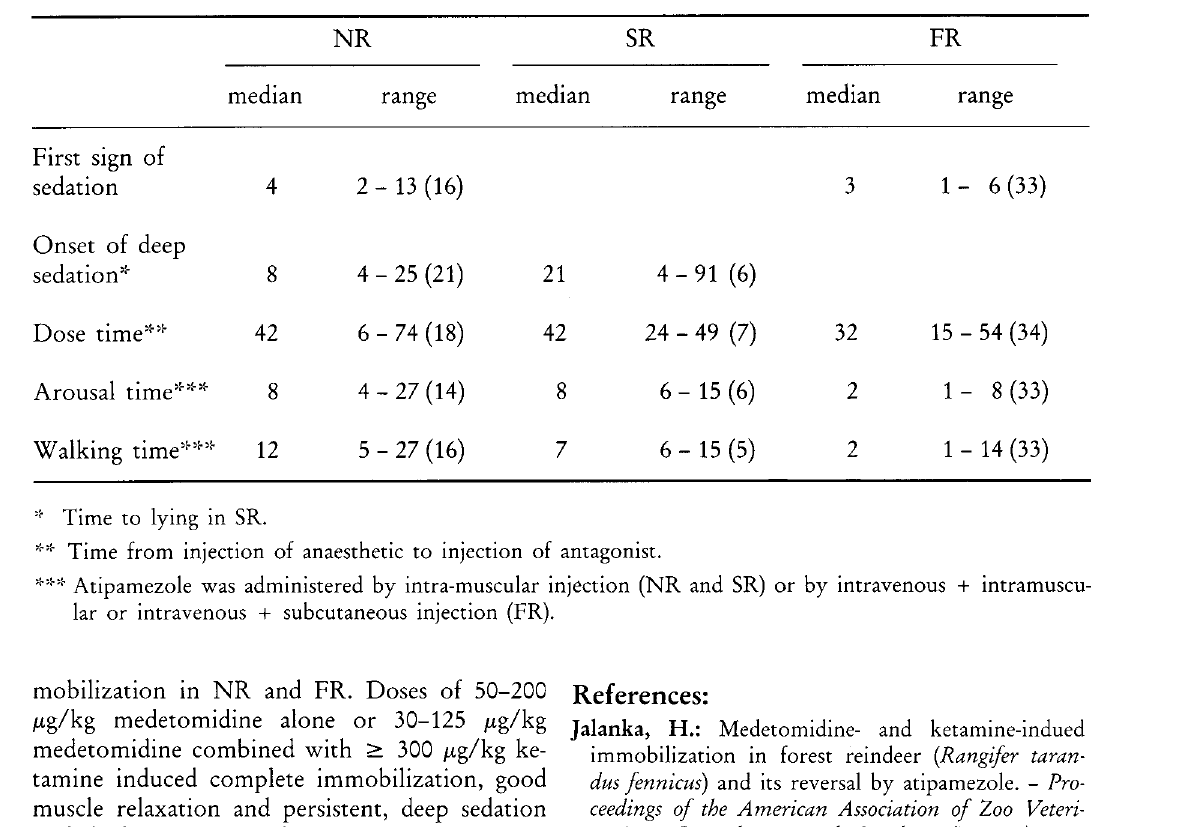
Table 2. Response times (min.) of Norwegian reindeer aged > 2 yrs (NR), Svalbard reindeer (SR) and wild forest reindeer (FR) to medetomidine, medetomidine-ketamine and atipamezole (number of